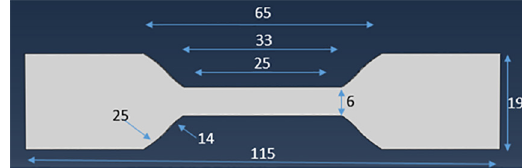
Figure 2. Illustration of Epoxy resin tensile test sample. Shown dimensions are in